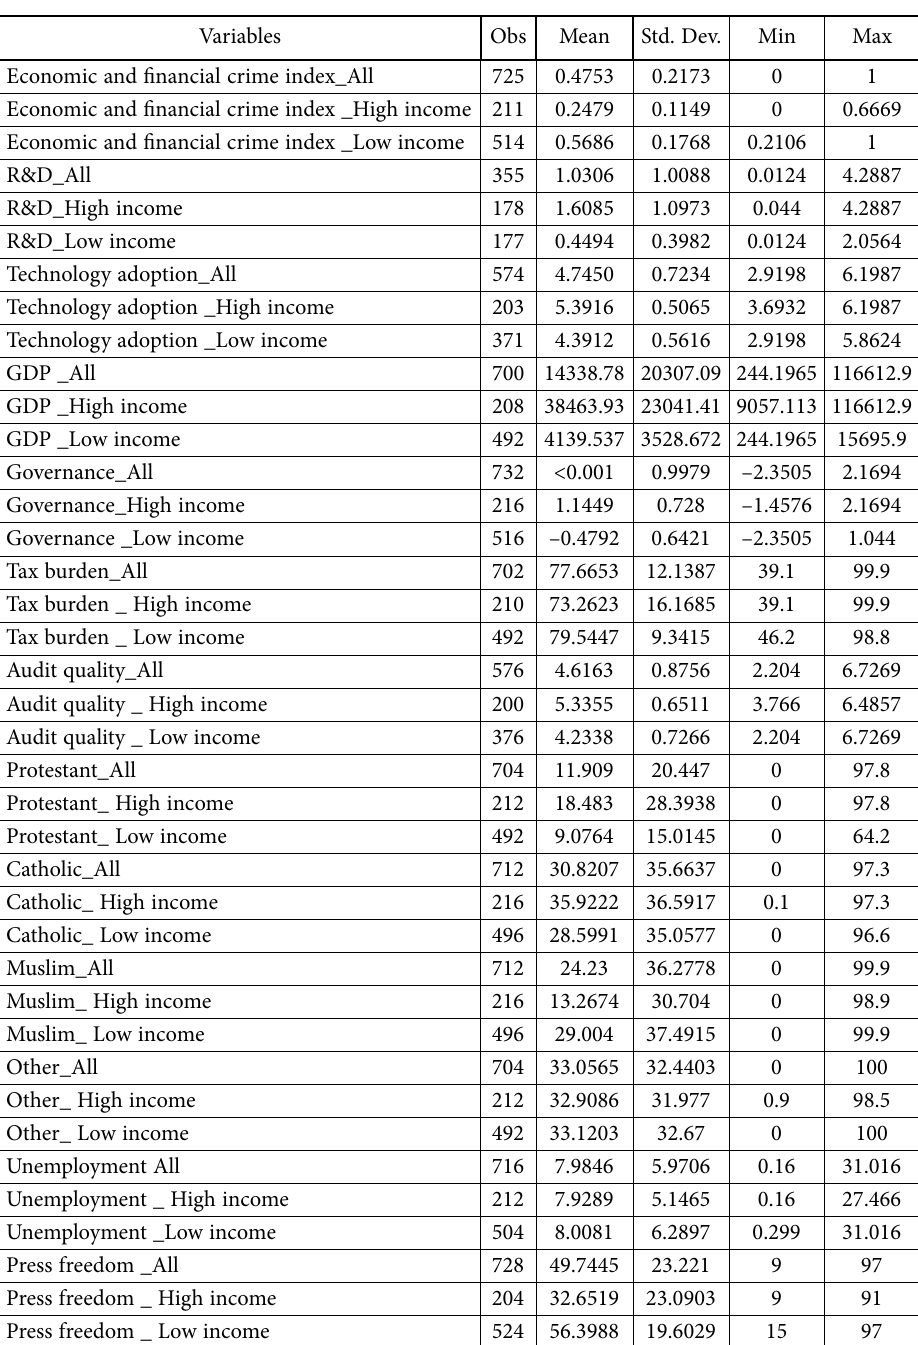
Table 2. Summary statistics, the entire sample (All), the high income countries’ subsample (High in- come) and the low income countries’ subsample (Low income) Variables